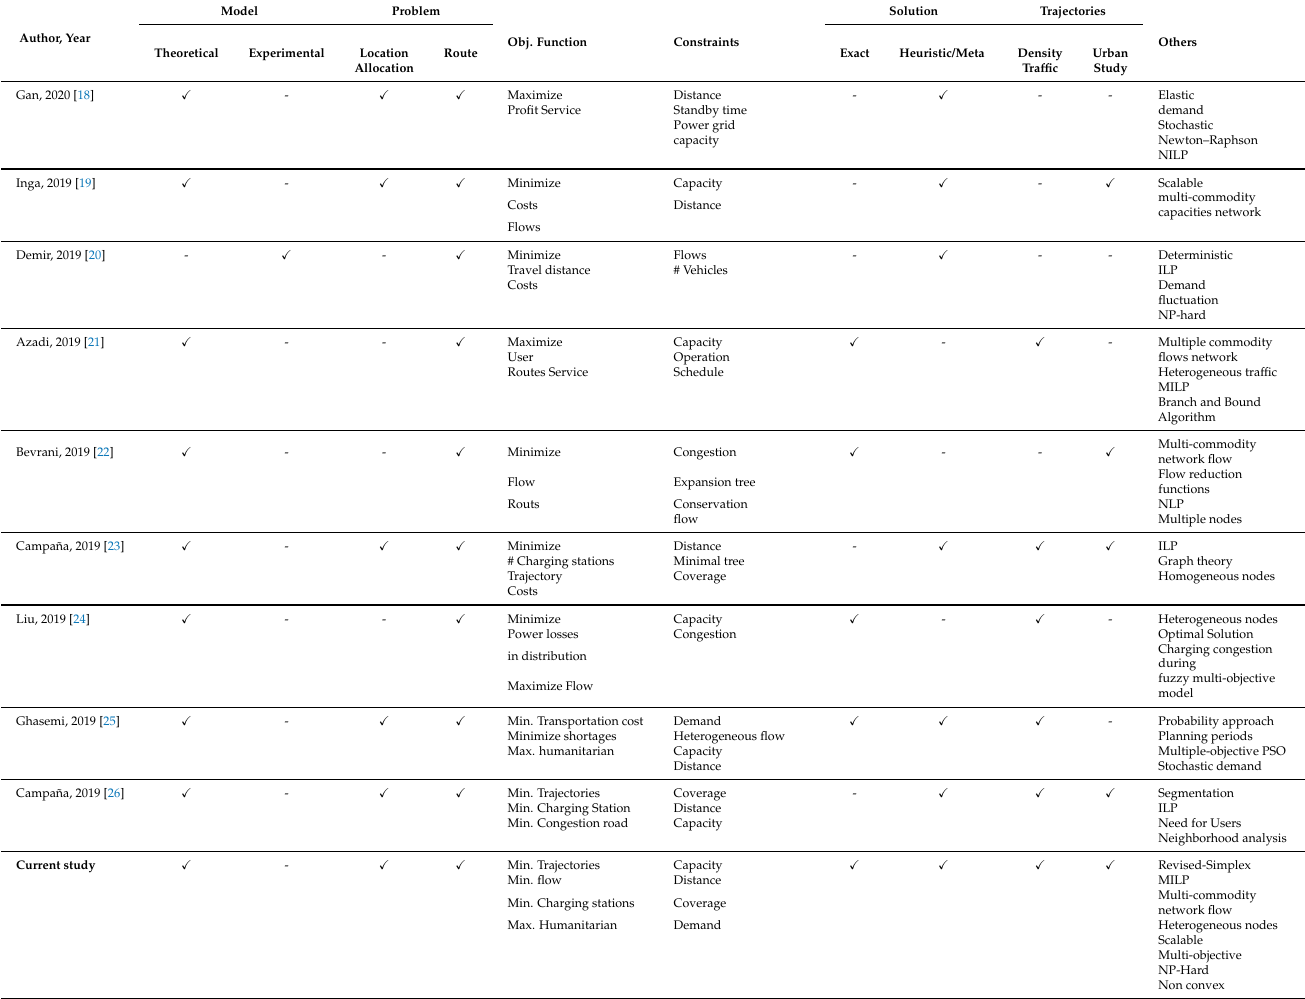
Table 2. Taxonomy of related studies.